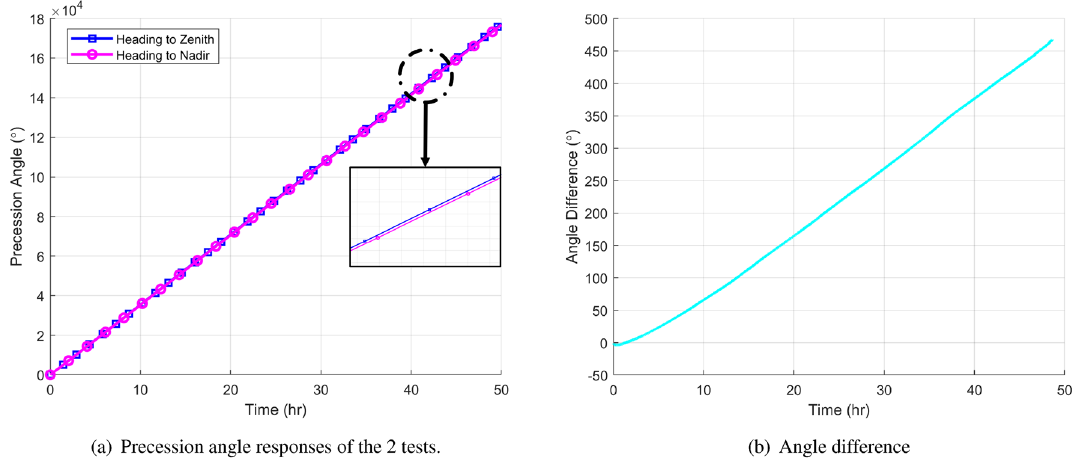
Figure 13. Dead area compensation verification experiment by using the earth earth rotation as a state-of-the-art result. The suggested future work would be further explore and optimize the error mechanisms of HRG RIG and this work can be adopted to MEMS RIG.